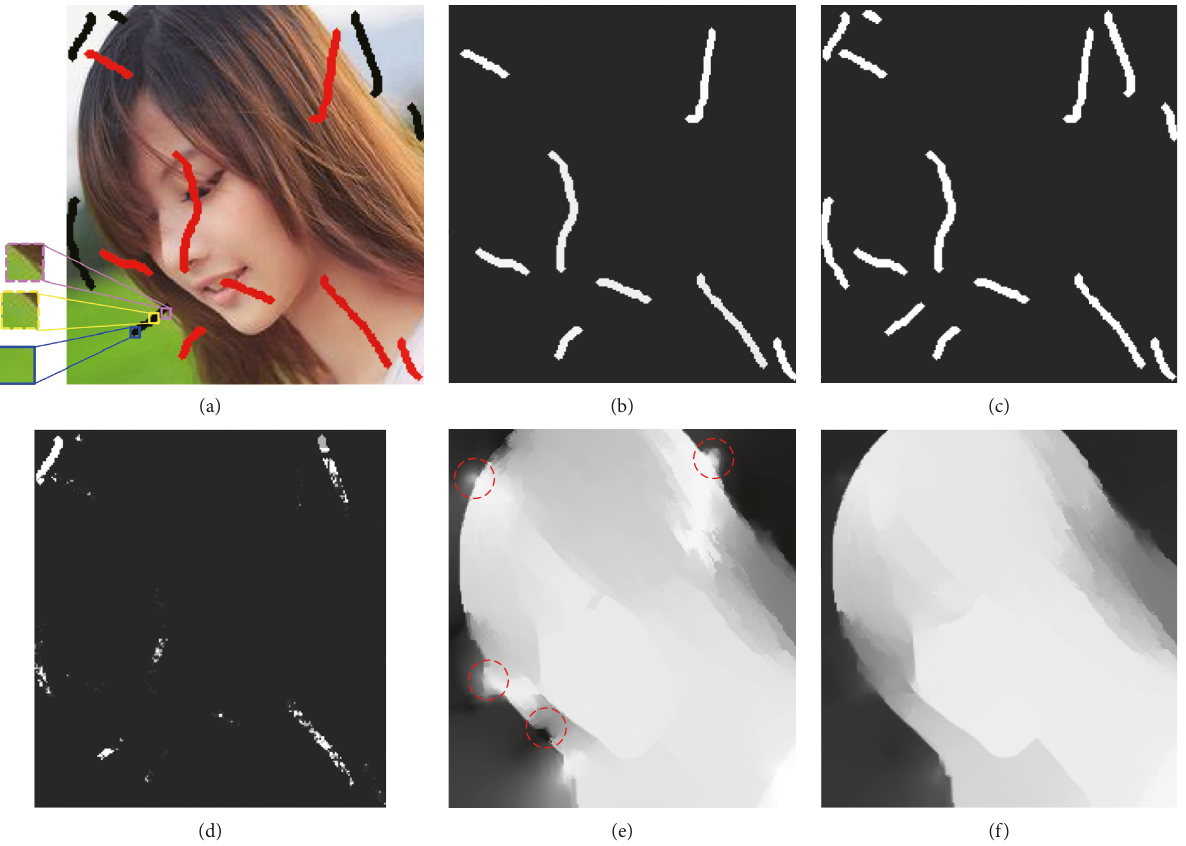
Figure 3: The demonstration of scribble confidence provided by the proposed method. (a) User scribbles. (b) Sparse depth. (c) Label mask. (d) Scribble confidence (the brighter the intensity, the higher the confidence of labeled pixels). (e) Depth-map of optimization method [6]. (f) Depth-map of confident optimization